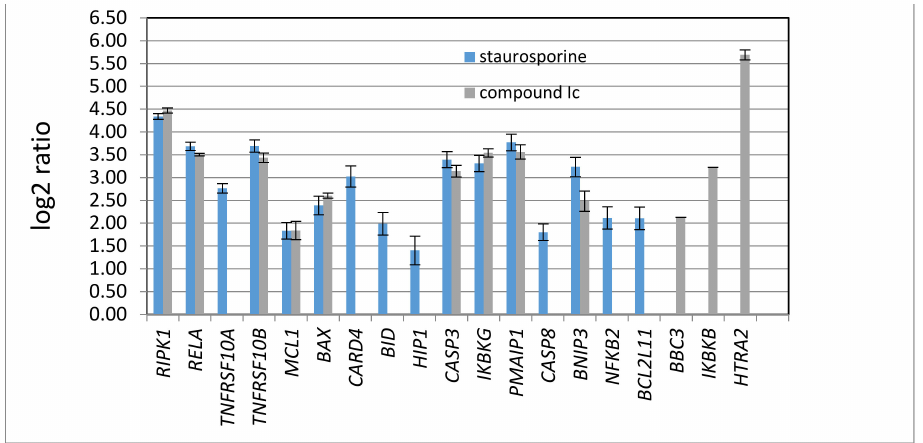
Figure 3. Human apoptosis array analysis of gene expression in K562 exposed to compound Ic at 10 µ M (5 × IC 50 ) for 18 h. Staurosporine (1 µ M) served as a positive control. Only apoptosis-related genes with statistically significant changes in expression are shown ( p < 0.05, t -Student). The fold of change was expressed as log2 ratio of gene expression in a test sample vs control sample (cells +